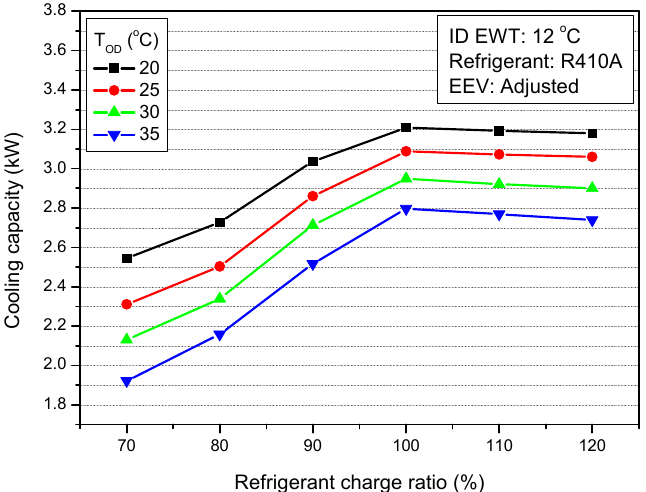
Figure 2. Cooling capacity with variation of refrigerant charge amount and T OD .